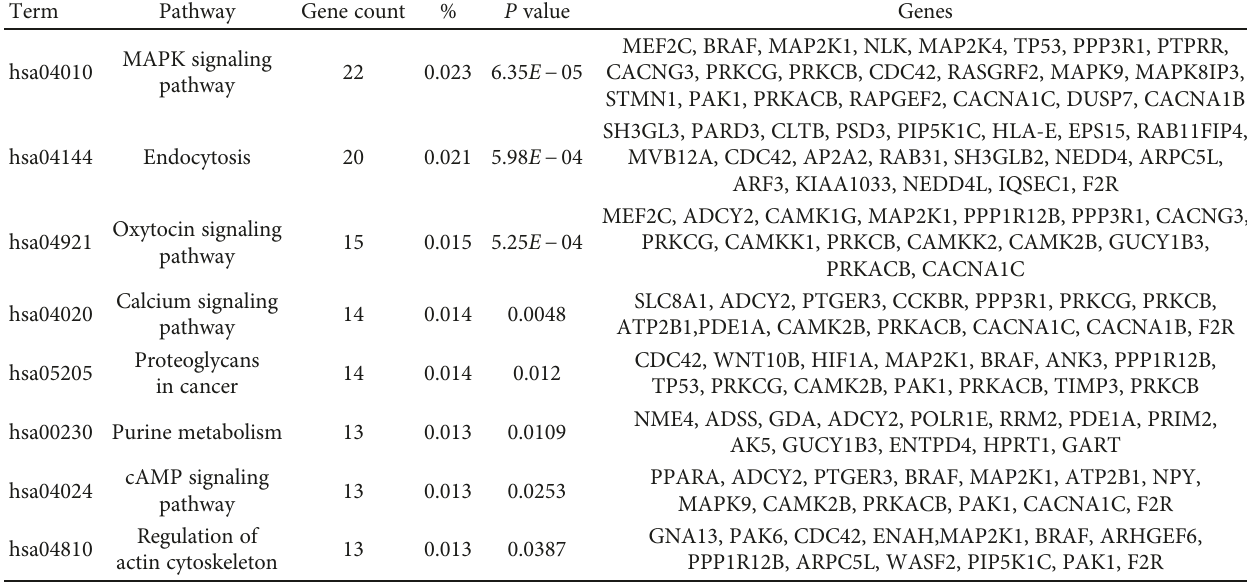
Table 2: KEGG pathway analysis of downregulation genes associated with glioma.